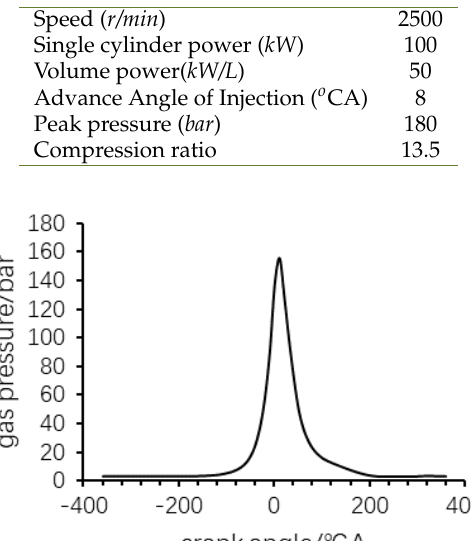
Table 1. Main performance parameters of diesel engines